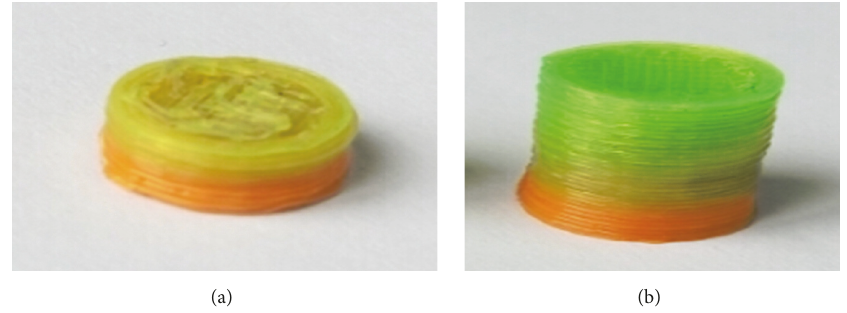
Figure 15: 3D printing objects at the temperature of 220 ∘ C: (a) blocked; (b) successful.